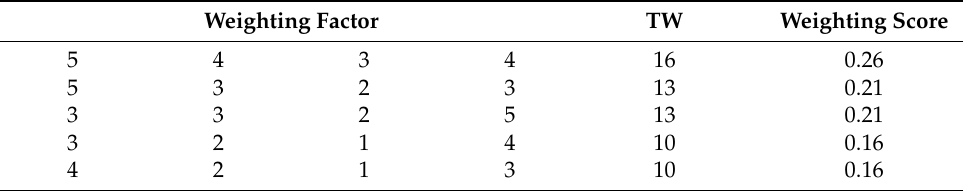
Table 5. Each expert’s